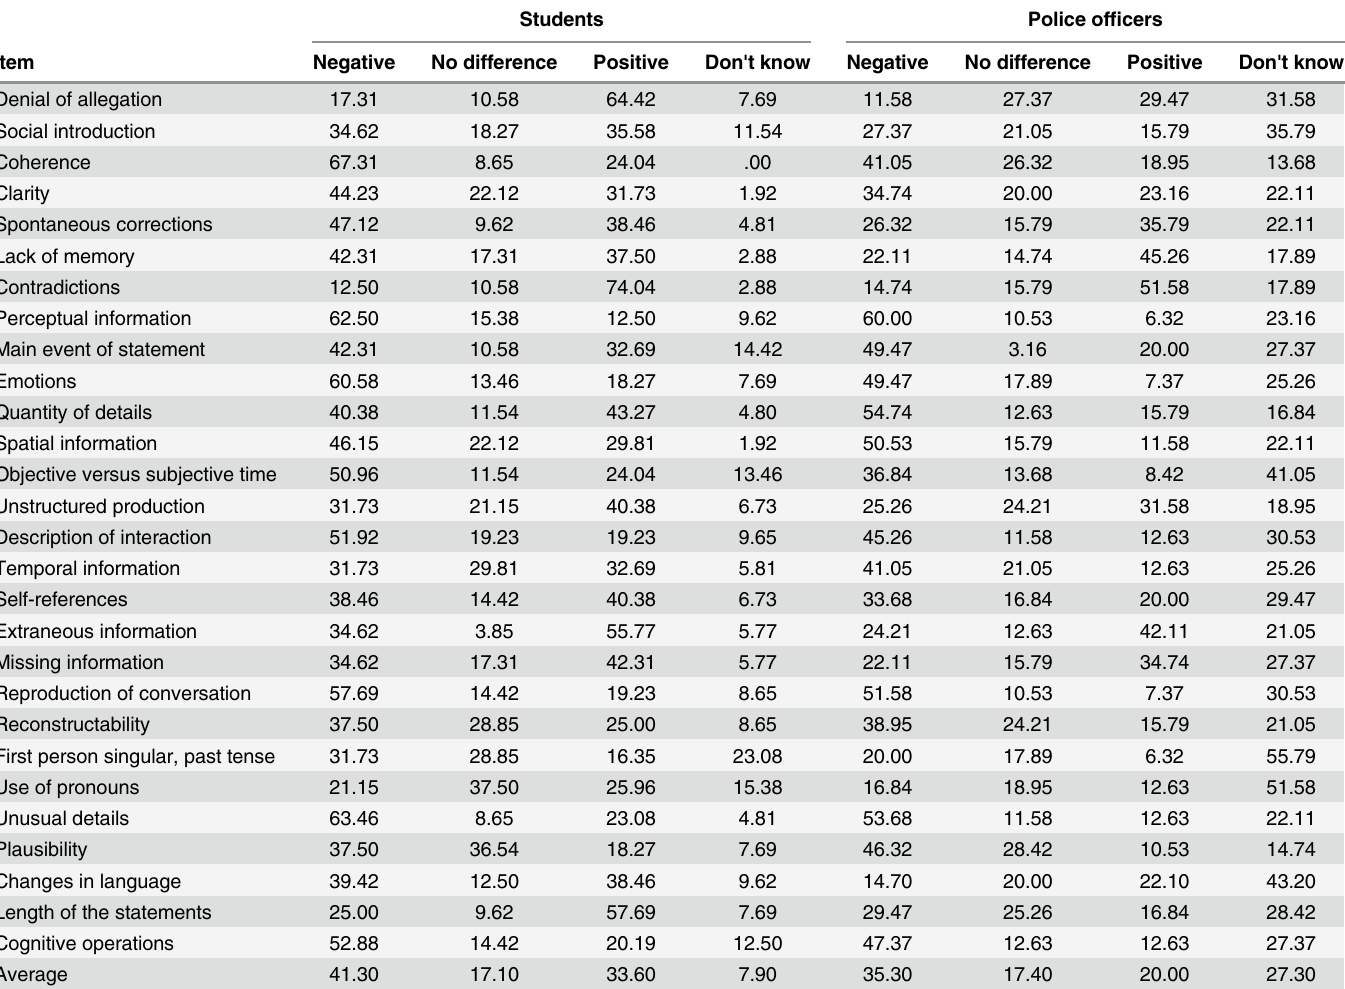
Table 3. Percentage of students (n = 104) and police officers (n = 95) who endorsed the answer